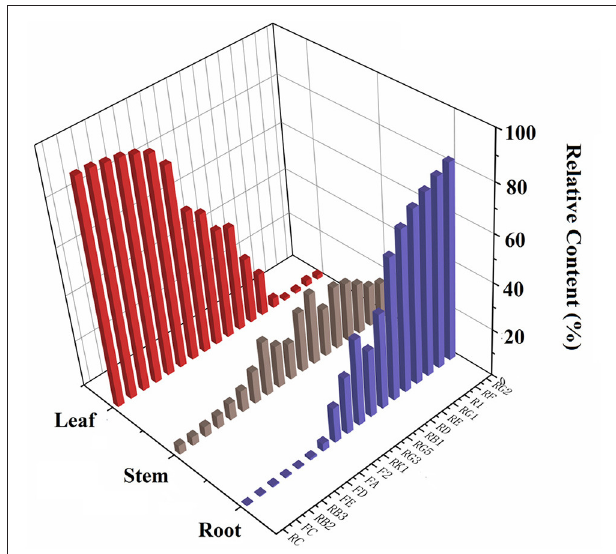
FIGURE 4 | The relative content of 18 saponins in different parts of P. notoginseng (Relative content = individual part content/sum contents of all parts).